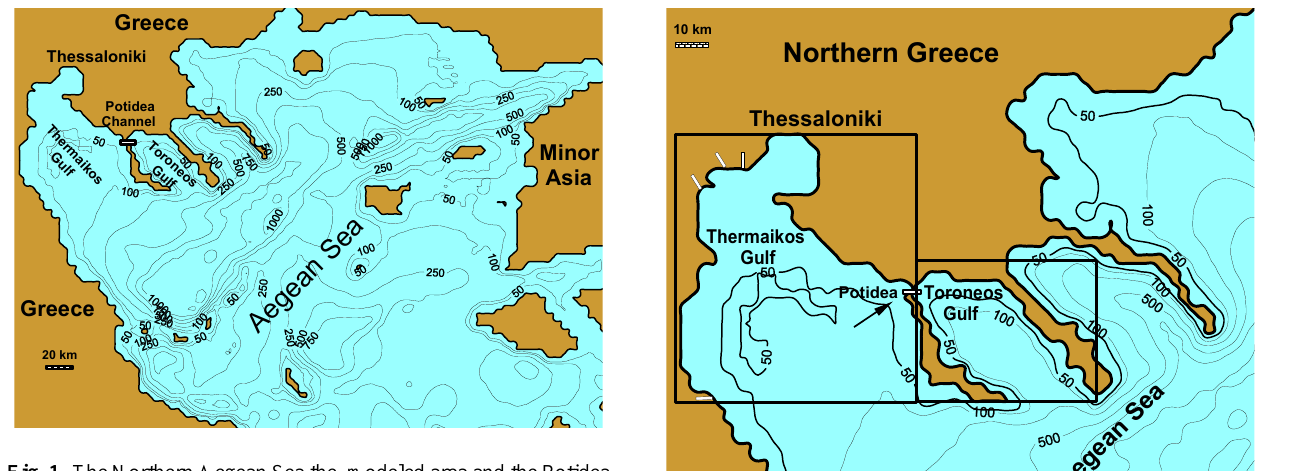
Fig. 3 Geometrical characteritics of a typical cross section of the channel.